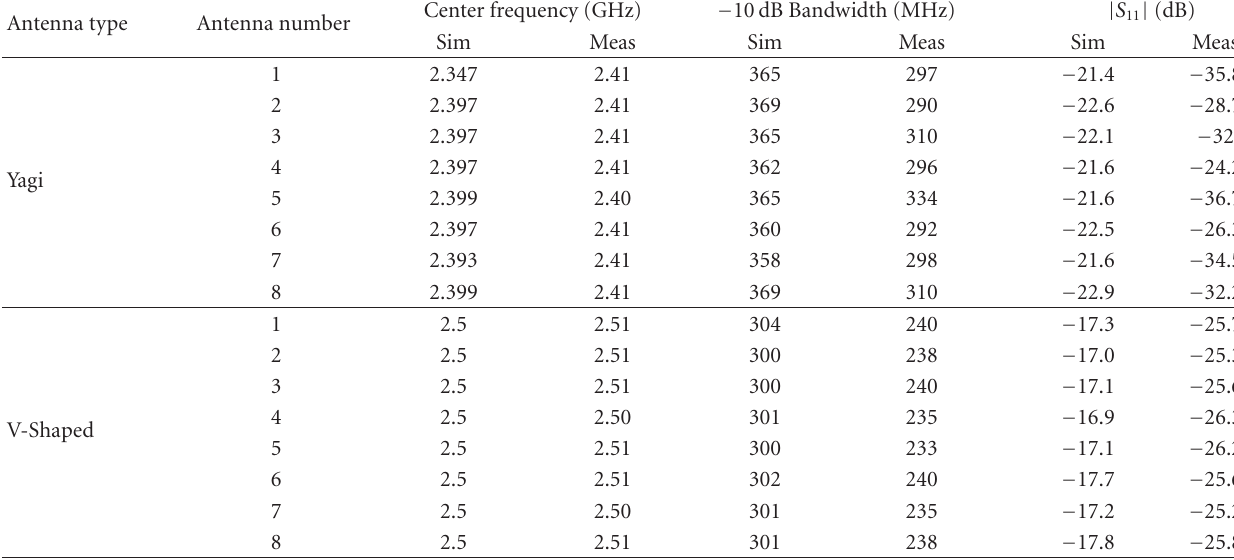
Table 1: Simulated and measured center frequency, − 10 dB matching bandwidth, and | S 11 | for the Yagi and the V-shaped antennas. Antenna